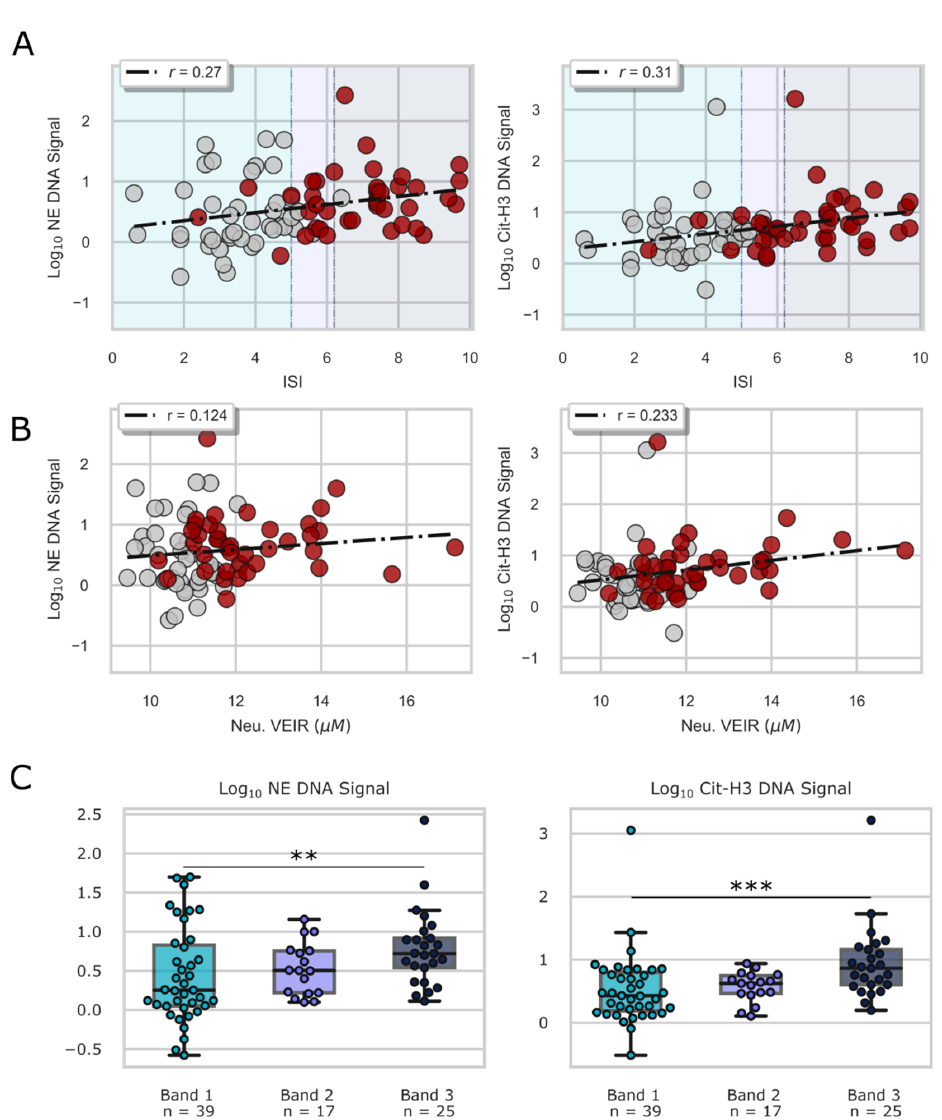
Figure 4. Quantity of neutrophil elastase (NE)-DNA and citrullinated histone H3 (Cit-H3)-DNA compared to IntelliSep Index (ISI). NE DNA and Cit-H3 DNA quantity vs. ( A ) IntelliSep Index and ( B ) neutrophil VEIR measurements. Gray and maroon markers indicate Control and Diseased patients, respectively. Teal, purple-blue, and dark-blue shaded regions indicate the range of ISI for the given interpretation band color. “r” values indicate Pearson correlation coe ffi cients. ( C ) Quantity of NE DNA and Cit-H3 DNA across IntelliSep interpretation band scores. ** indicates p < 0.01, and *** indicates p < 0.001.